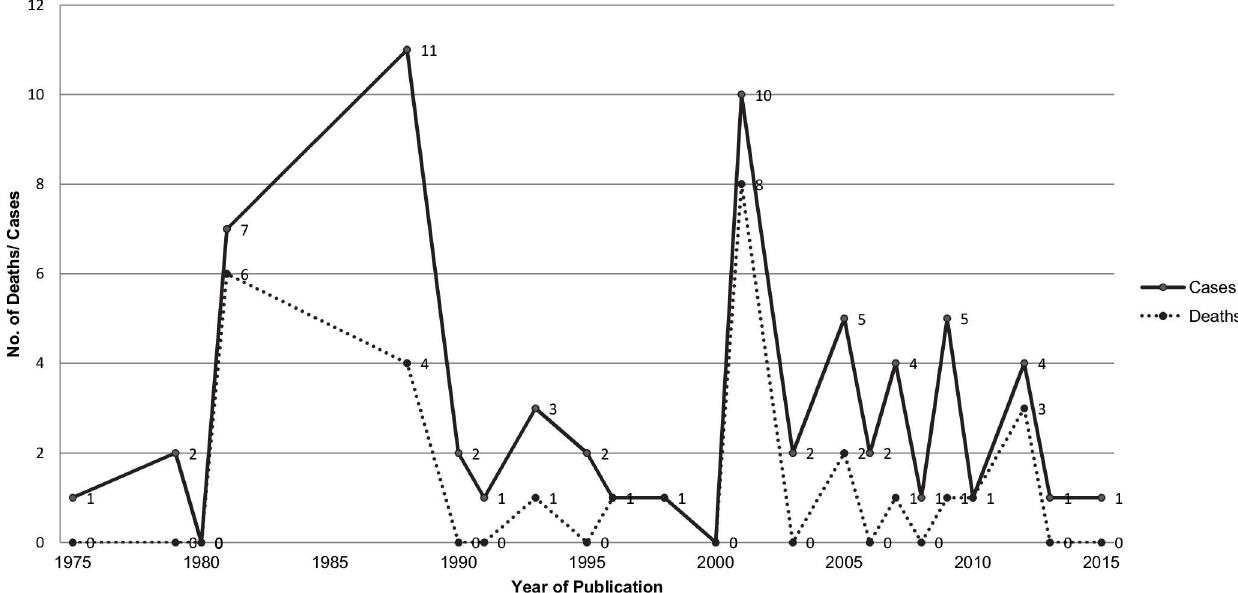
Fig 1. Numbers of melioidosis casesand deaths from published case reports by year of publication, 1975 to 2015.